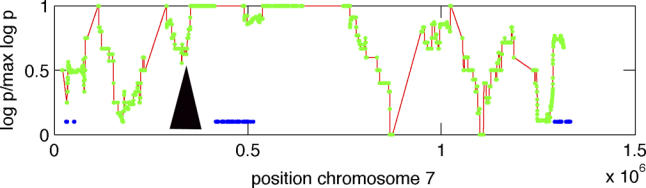
Linkage Disequilibrium surrounding pfcrt (MAL7P1.27) in FCB and Dd2 on Chromosome 7Scores were generated by calculating the probability of observing the same genotype by chance over a moving 40-kbp window (with the probability of observing the same genotype for any one SFP by chance placed at 0.33). The plot shows the ratio between the probability and the maximum possible probability for regions with at least four SFPs, with 1 indicating the best possible score. The position of antigenic variation clusters (vars, stevors, or rifins), are shown in blue and are marked. SFPs mapping to these genes were excluded from the calculations because our data indicate that mitotic recombination may be occurring in these genes. pfcrt, which is located between bases 307,926 and 311,020 on Chromosome 7, is shown as a black triangle. The trough at pfcrt is likely to be due to the strong selective pressure on pfcrt, and is consistent with the observation that FCB and Dd2 have different alleles of pfcrt even though published SNP data also shows disequilibrium in surrounding regions [5]. Data for other chromosomes are shown in Figure S1.